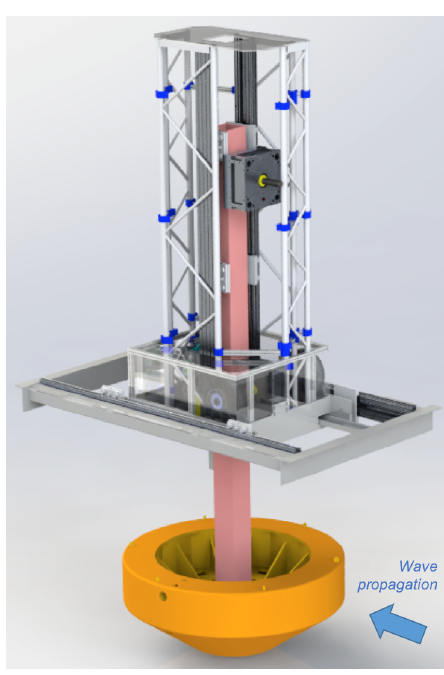
Fig. 2: A rendering of the WaveBot device.